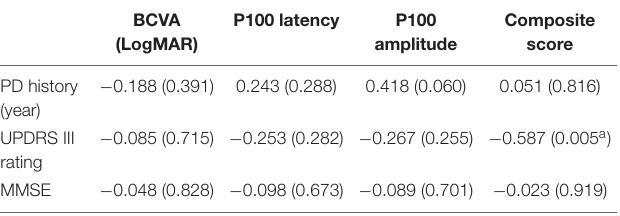
TABLE 4 | Correlations between visual function and clinical data in PD